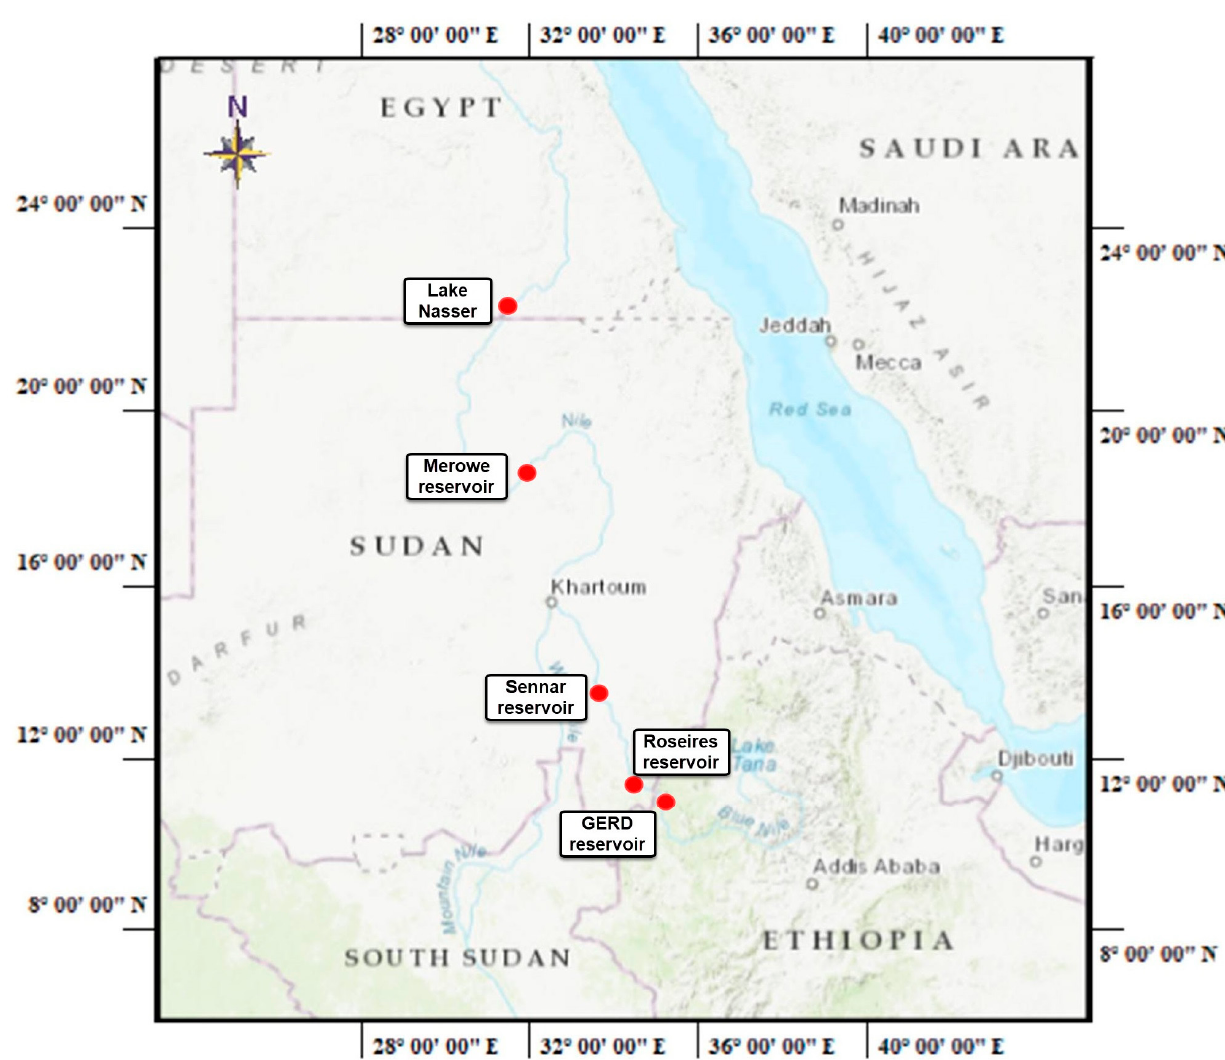
Figure 1. Reservoirs through study area from GERD to AHD.